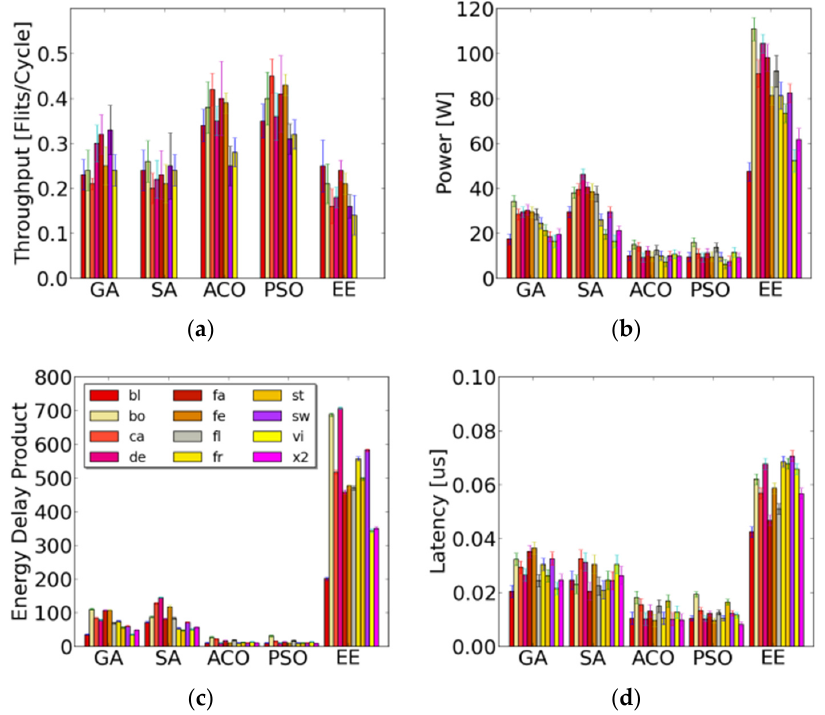
Figure 11. PARSEC [47] benchmarks comparison for 6 × 6 NoC ( a ) throughput, ( b ) power, ( c ) latency, and ( d ) energy delay product.